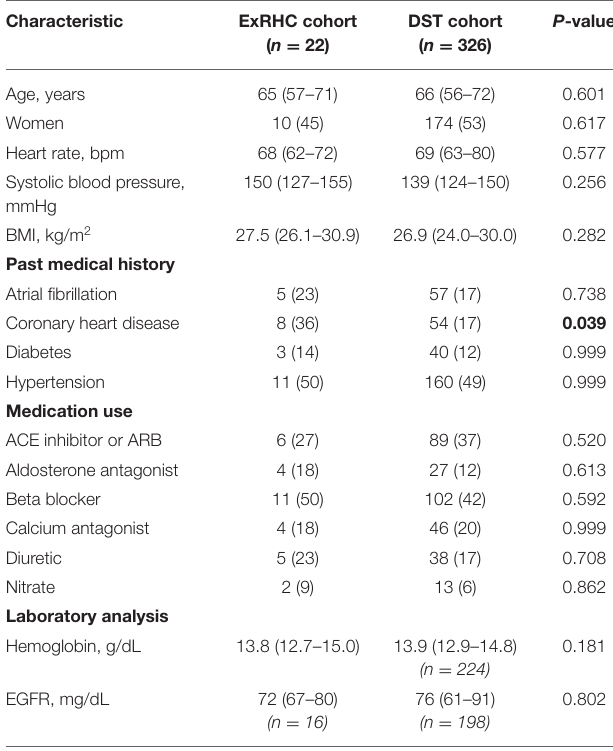
TABLE 1 | Baseline characteristics of the study